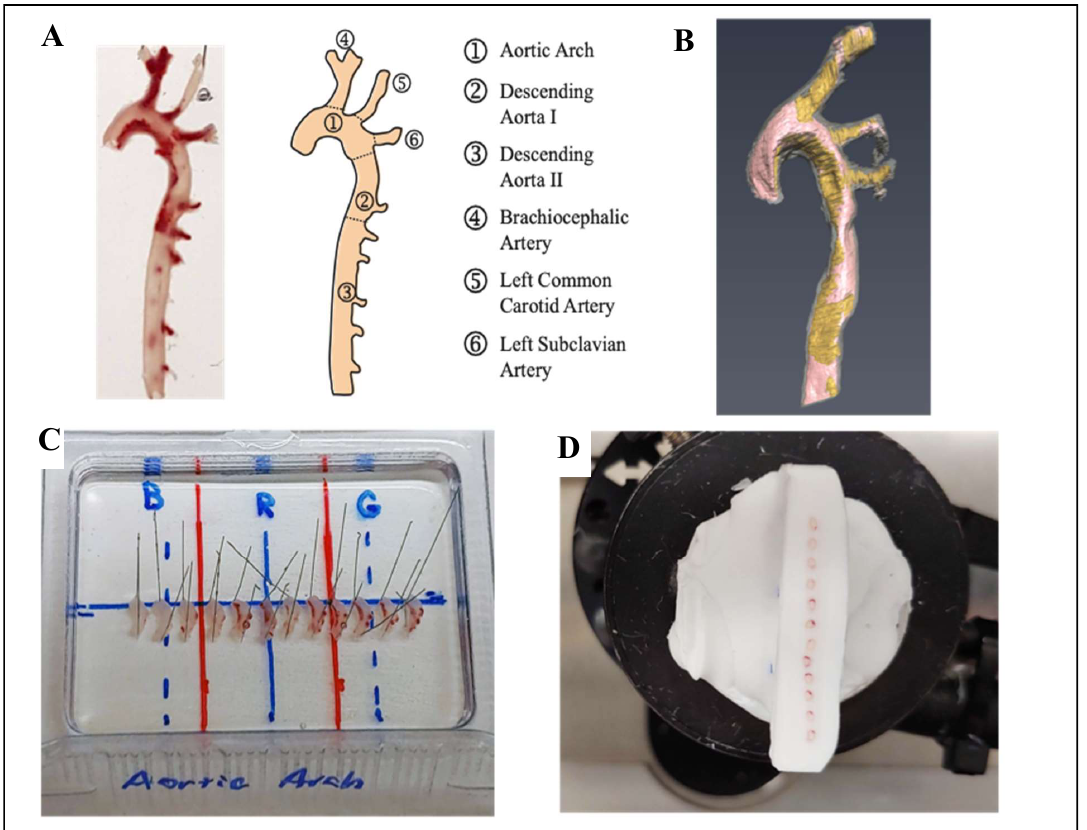
Figure 1. Aorta Cryosectioning A . Example of one aorta from ApoE −/− mice and schematic representation of the different regions of the aorta including pre-embedding cut sites (dashed lines); B . Example of the visualization of the aortic arteriosclerotic plaque (colored in yellow) using 14T-magnetic resonance imaging (MRI); C . After MRI analysis, aortas from the same study were cut, each region was pinned into alignment, embedded in Optimal Cutting Temperature (OCT) compound and stored at −20 °C for 24 h. Blue letters B, R, and G only represent marks used as orientation and spacing guides. D . The resulting cryoblock was then sectioned, creating arrays of aortic slices of similar orientation and position for immunofluorescence analysis.